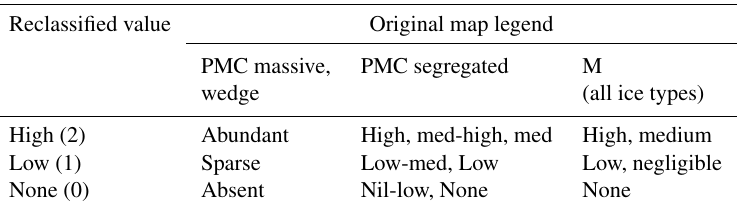
Table 2. Raster reclassification used to produce the ground ice abundance difference map between the Permafrost map of Canada (PMC) (Heginbottom et al., 1995) and the models